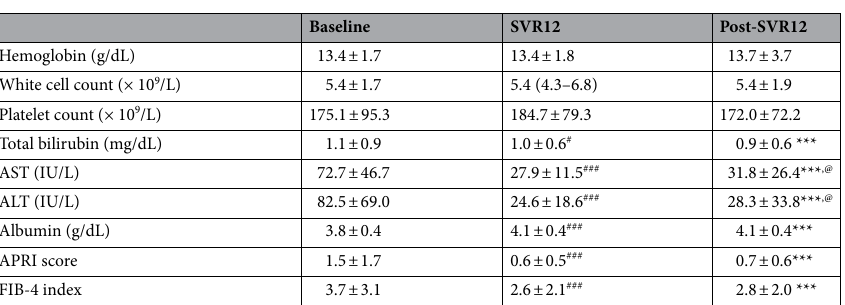
Table 2. Laboratory paraemeters and serum fibrotic scores in patients with chronic HCV treated with direct- acting antivirals during SVR 12 and post-SVR12 (n = 89). Baseline vs. SVR12: # p ≤ 0.05, ## p ≤ 0.01, ### p ≤